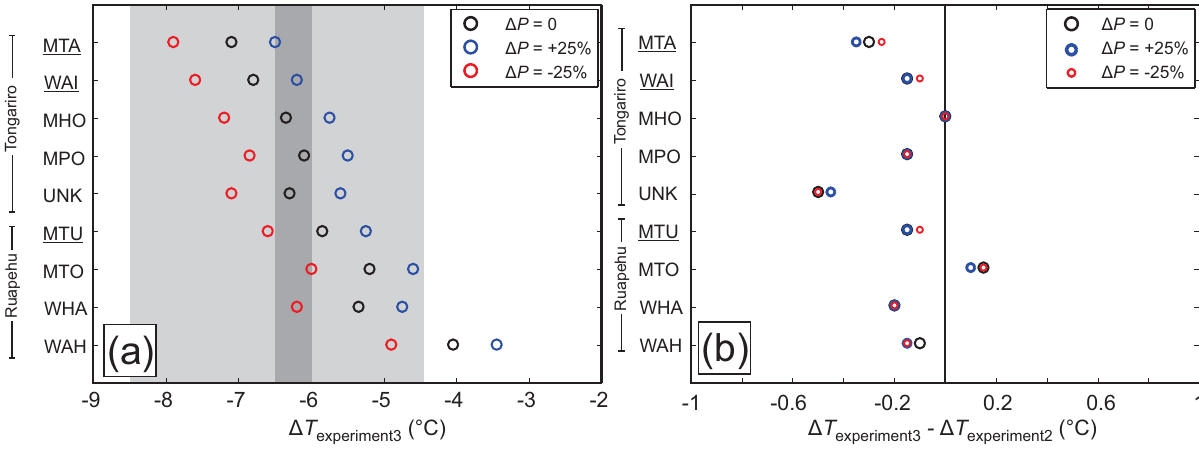
Figure 7. (a) Modelled, steady-state ice geometry on Mt Ruapehu when (cid:49)T =− 5.2 ◦ C and (cid:49)P = 0 (Experiment 2). This represents the best- fit simulation for the WHA catchment. (b) Steady-state ice geometry on Tongariro massif when (cid:49)T = − 6.7 ◦ C and (cid:49)P = 0 (Experiment 2). This is the best fit to the inferred LGM terminus in the WAI catchment; however, note the ice overspill at the lateral margins.